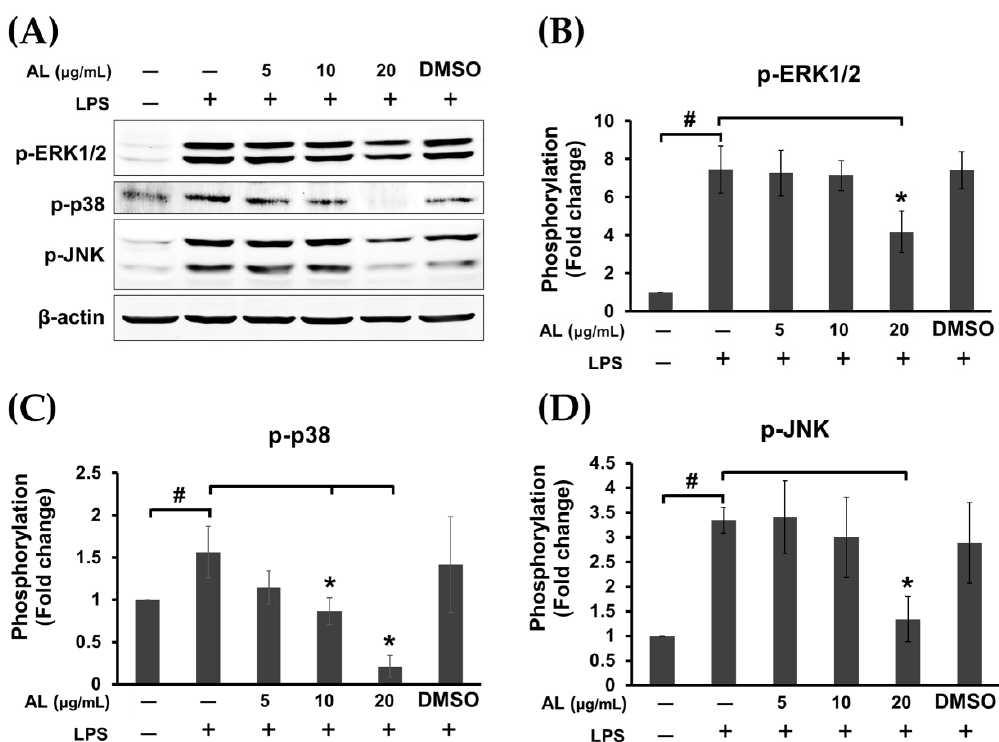
Figure 6. ( A ) Western blot analysis for the inhibitory effects of AL extract on the phosphorylation of mitogen-activated protein kinases (MAPKs), including ERK1 / 2, p-38, and JNK, in LPS-induced cells treated with AL extract at various concentrations for 24 h; degradation of I κ B; ( B ) quantitative analysis for the phosphorylation of ERK1 / 2; ( C ) quantitative analysis for the phosphorylation of p -38; ( D ) quantitative analysis for the phosphorylation of JNK. Beta actin ( β -actin) was detected and used as an internal control. Data are representatives of three replicates and shown as mean ± SD; # p < 0.05 (compared to the untreated control) or * p < 0.05 (compared to the LPS-treated group).